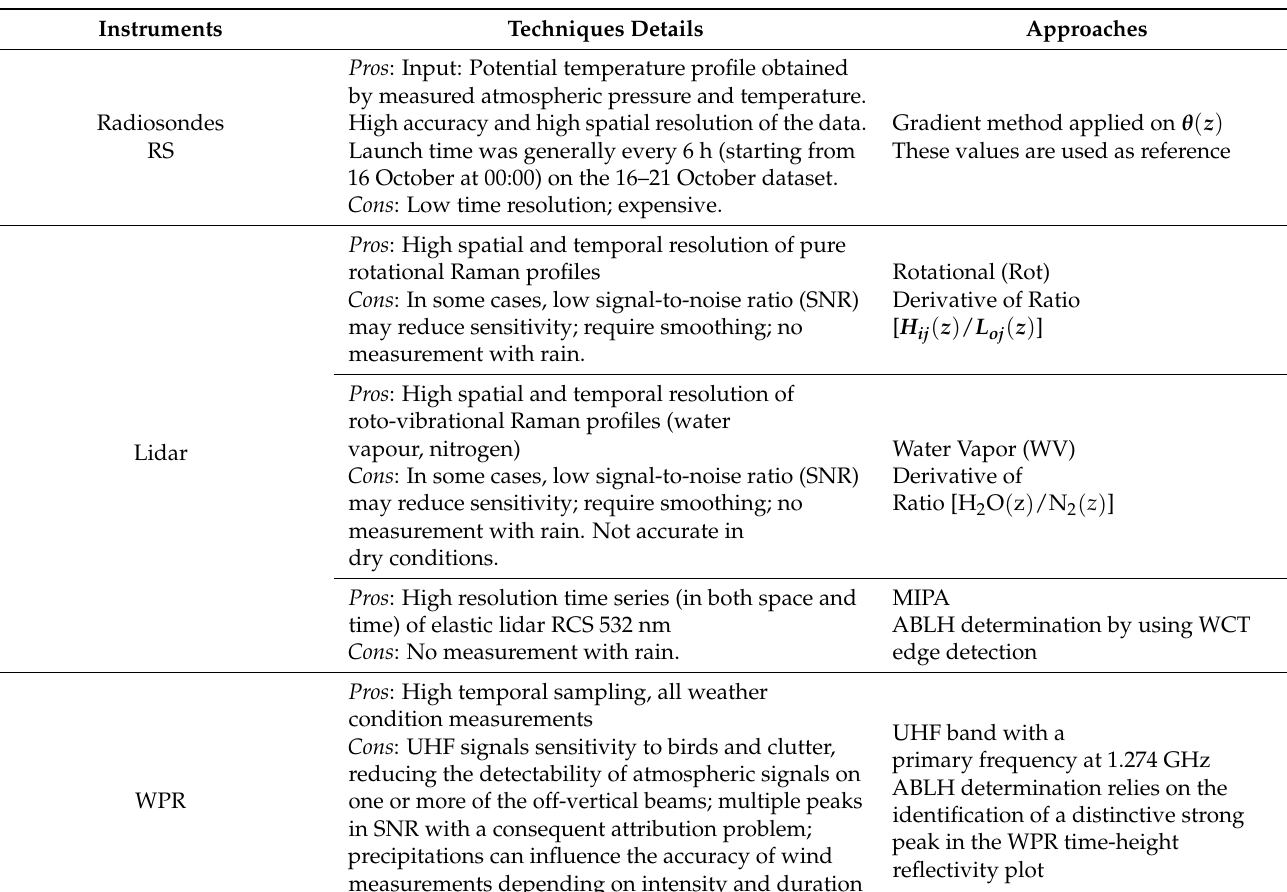
Table 1. Summary of the considered instruments/approaches used to determine the ABLH. Instruments Techniques Details Approaches